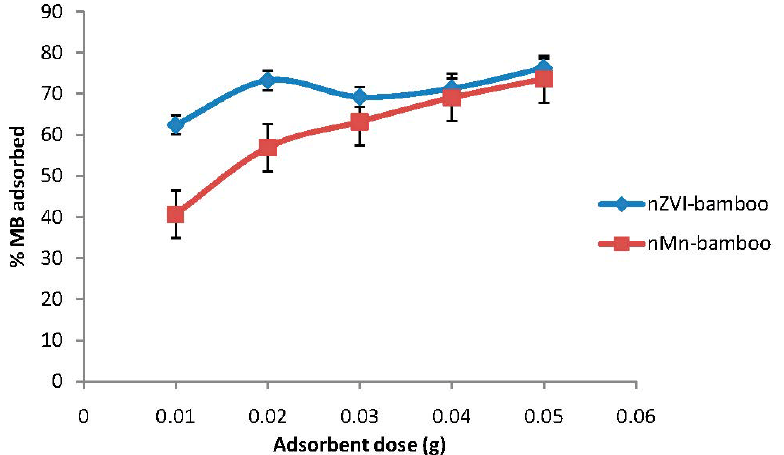
Figure 4. Effect of pH ( wt = 0.02 g, C